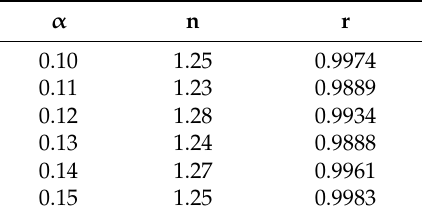
Table 6. Reaction order based on the Crane